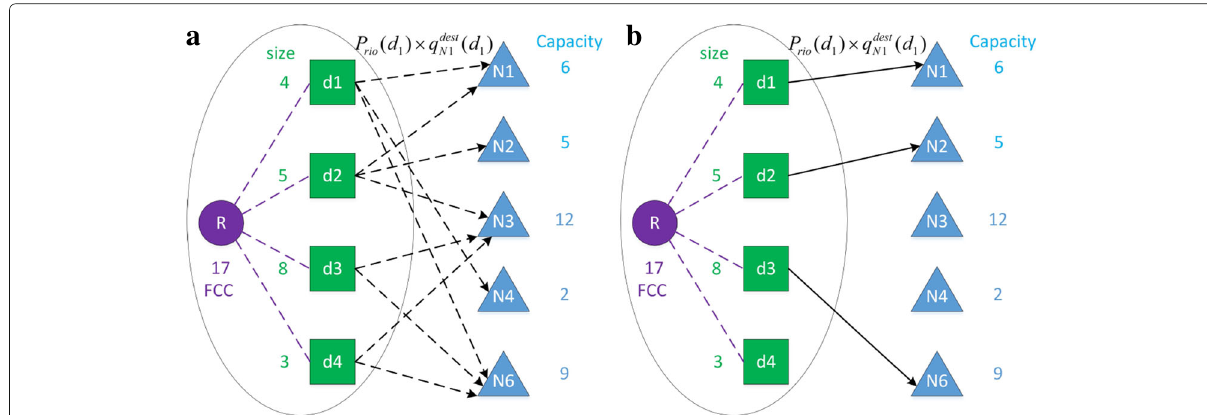
Fig. 4 A demonstration of data chunk assignments. a Possible assignments. b A feasible